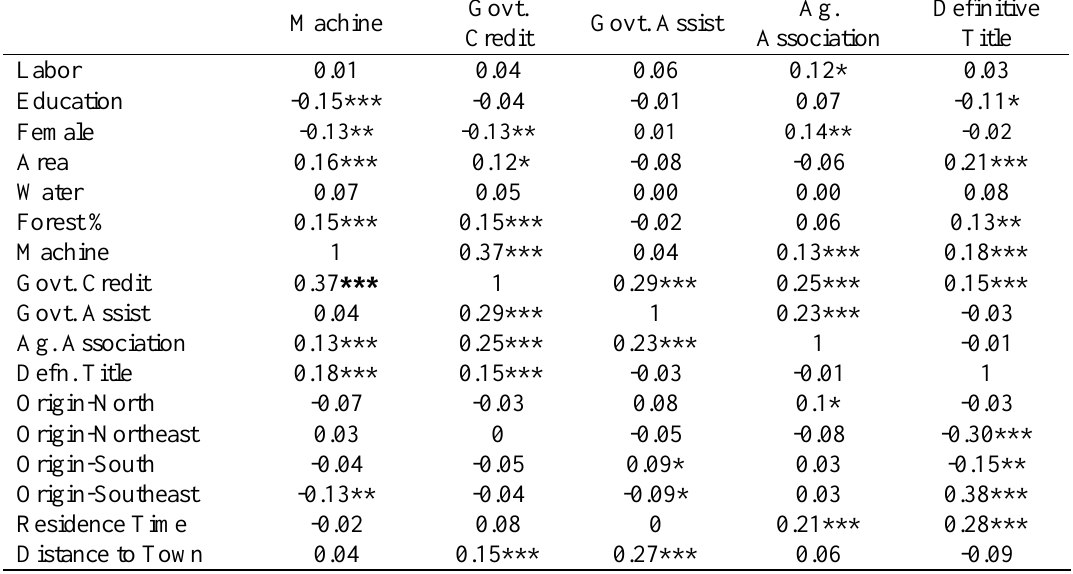
Table A3.1: Correlation table for all explanatory variables analyzed in this study, ctd.